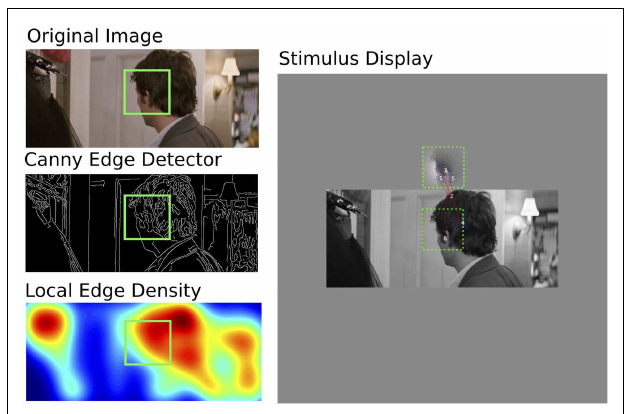
FIGURE 1 | Illustration of stimulus generation and example of typical eye movements. Left Column – Stimulus Generation: (middle) a Canny Edge Detector located the edges in a source image (top). A Gaussian weighting function ( σ x,y = 2˚) was used to determine the mean number of edges in an area the size of the search target.This avoided the selection of targets with too few (e.g., blank regions of wall or sky) or too many (e.g., grass or blinds) features for localization.The green square (not shown in the experiment) illustrates the location of the search target selected with this method. Right Column – Display and Eye Movements: the target was placed in a window above the search image, its mean luminance (50cd/m 2 ) and rms contrast (0.2%) did not match the original in order to force a structural search. Fixations are depicted as blue circles, whose diameter represents fixation duration. Saccades are depicted as red vectors (not shown in the experiment). Example data are from Subject 5. Subjects were asked to locate the patch within the image and to click a mouse cursor on its